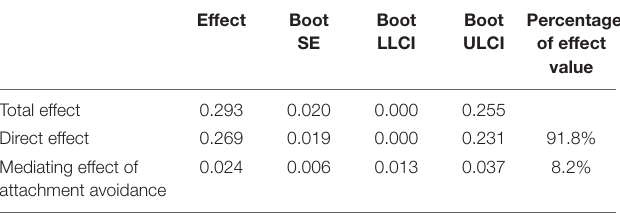
TABLE 3 | Analysis of Total effect, direct effect, and mediating